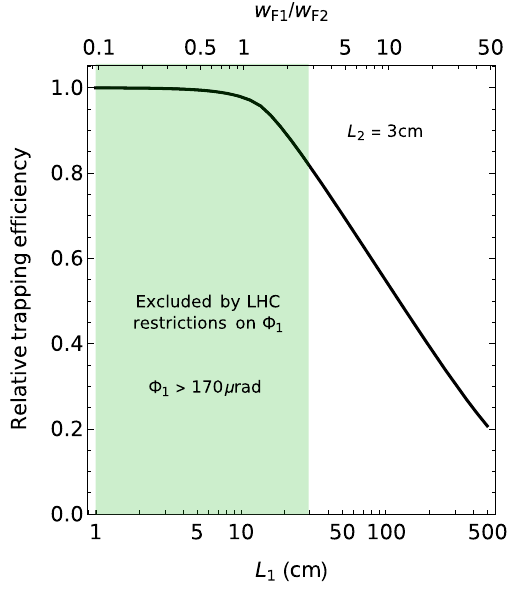
Fig. 4 Trapping efficiency of the double-lens scheme as a function of the distance L 1 and, on the upper scale, of the ratio of focal windows w /w F 1 F 2 .ThetwoscalesarerelatedviaEq.(1).Whenthefocalwindow of lens 1 is embedded in that of lens 2, i.e. when w F 1 /w F 2 < 1, there is a plateau on the trapping efficiency. Increasing this ratio up to w /w = 2 . 8, to make the setup compatible with the LHC beam F 1 F 2 pipe, reduces the efficiency to 82% of the initial